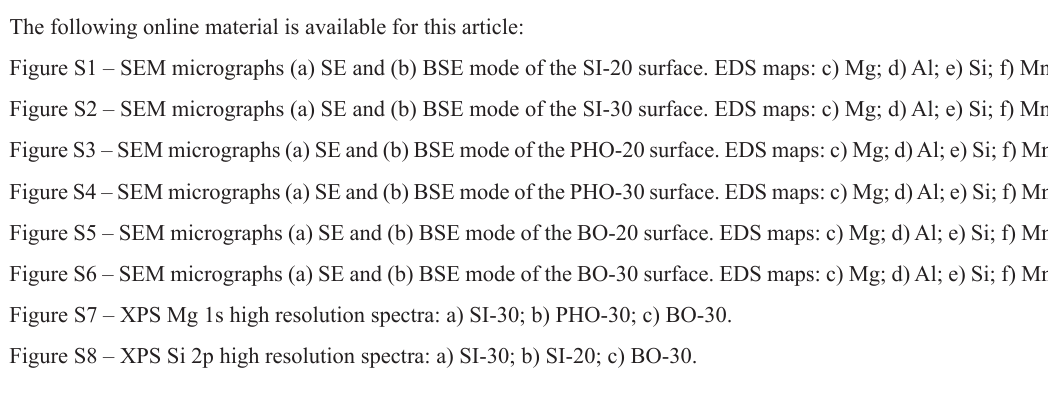
Figure S1 – SEM micrographs (a) SE and (b) BSE mode of the SI-20 surface. EDS maps: c) Mg; d) Al; e) Si; f) Mn. Figure S2 – SEM micrographs (a) SE and (b) BSE mode of the SI-30 surface. EDS maps: c) Mg; d) Al; e) Si; f) Mn. Figure S3 – SEM micrographs (a) SE and (b) BSE mode of the PHO-20 surface. EDS maps: c) Mg; d) Al; e) Si; f) Mn. Figure S4 – SEM micrographs (a) SE and (b) BSE mode of the PHO-30 surface. EDS maps: c) Mg; d) Al; e) Si; f) Mn. Figure S5 – SEM micrographs (a) SE and (b) BSE mode of the BO-20 surface. EDS maps: c) Mg; d) Al; e) Si; f) Mn. Figure S6 – SEM micrographs (a) SE and (b) BSE mode of the BO-30 surface. EDS maps: c) Mg; d) Al; e) Si; f) Mn. Figure S7 – XPS Mg 1s high resolution spectra: a) SI-30; b) PHO-30; c) BO-30. Figure S8 – XPS Si 2p high resolution spectra: a) SI-30; b) SI-20; c)